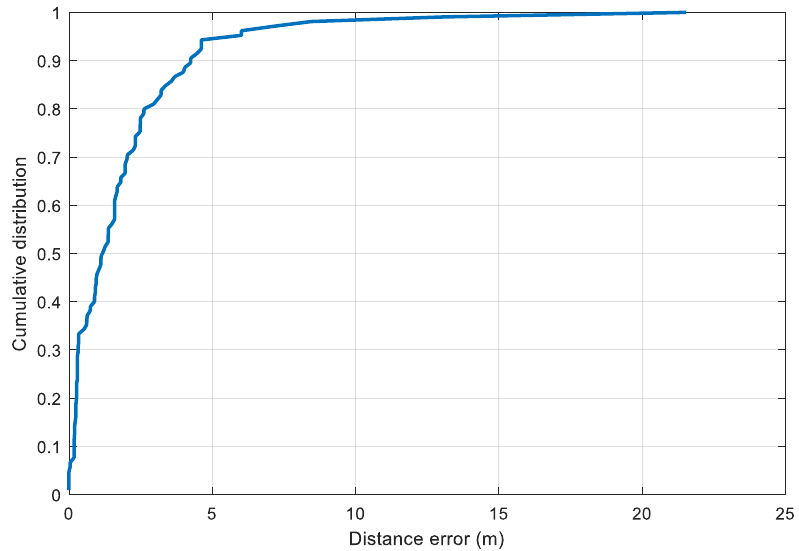
Figure 9. Cumulative distance errors with the selected parameters for the LDPL model in the obstacle-free setup.